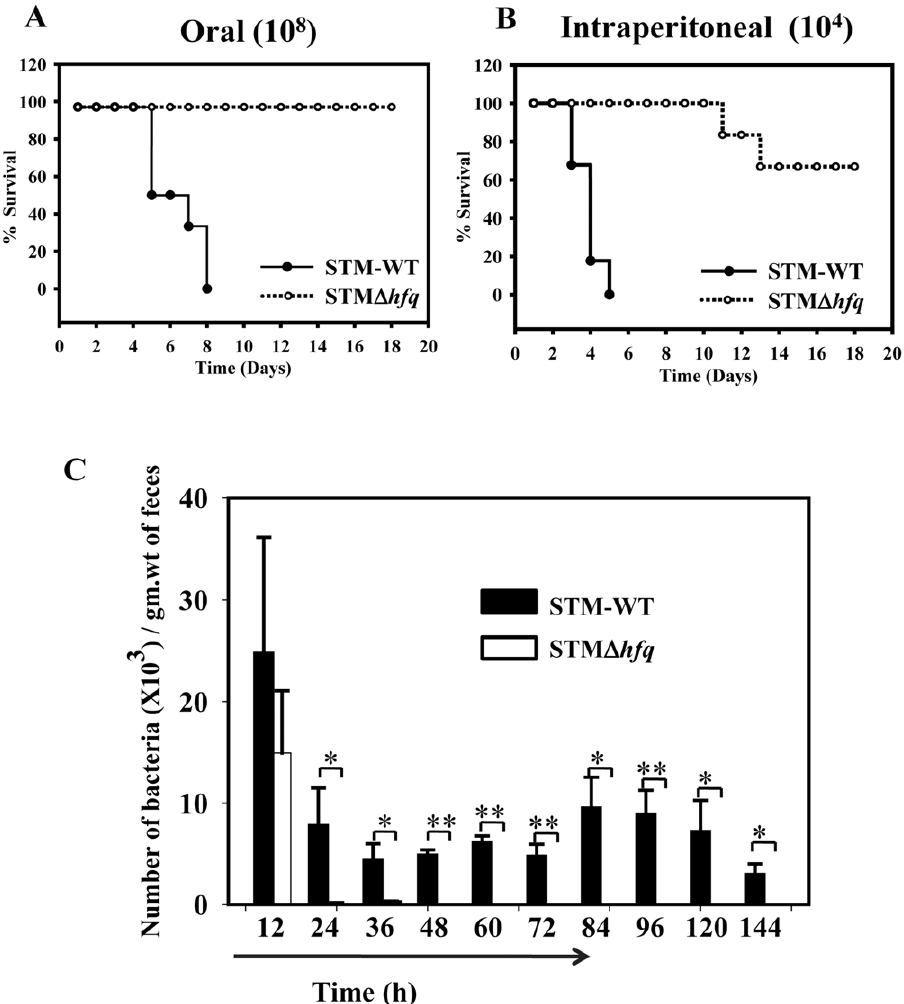
Figure 2. STM D hfq mutant is highly safe for infection in murine model. (A & B) Survival curves. Mice were infected orally (A) at a dose of 10 8 or intraperitoneally (B) with a dose of 10 4 bacteria per mouse (n=10) and mice were observed twice daily for survival. (C) Reduced fecal shedding of the STM D hfq . Mice were infected orally with the STM-WT or STM D hfq mutant strains at a dose of 10 7 bacteria/mouse. Uninfected mice were used as control. Fresh fecal pellets were collected at the indicated time points and shedding was determined by plating on culture media. Data is represented as the number of bacteria per gram weight of the fresh fecal pellets. Shown are the combined results from two experiments with 5 mice in each group. Statistical significance was defined as follows: (*p , 0.05) (Student’s t test & Fischer’s exact test).